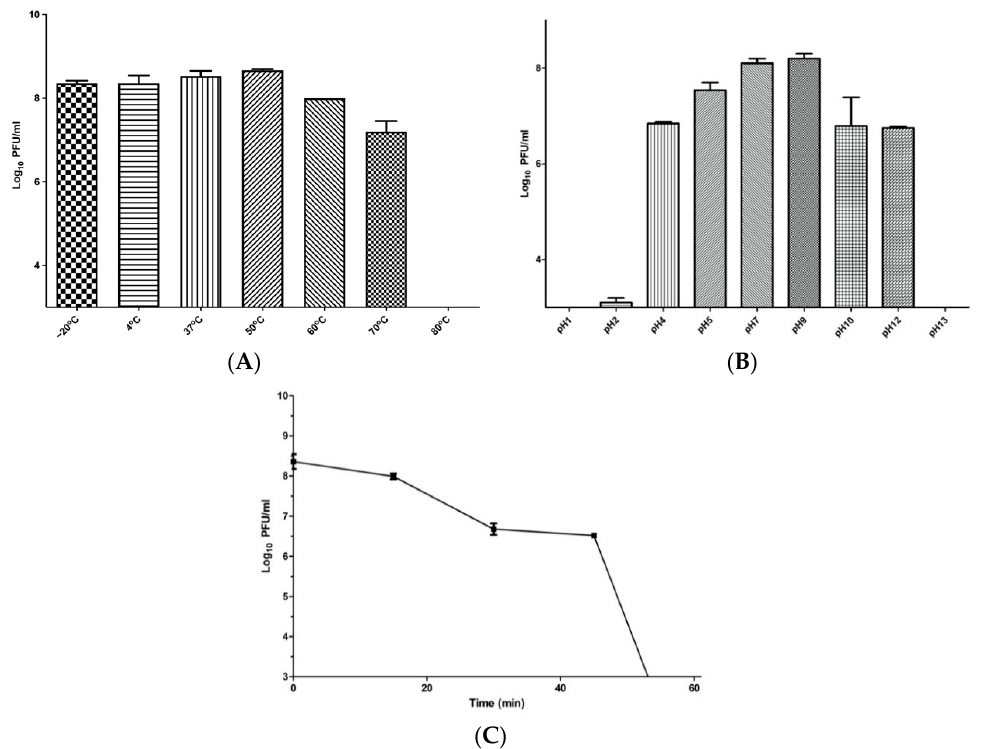
Figure 5. These diagrams represent the stability of phage ZCKP 8 at different temperatures ( A ), at different pH values ( B ), and under UV lamp ( C ). PFU: Plaque forming unit.